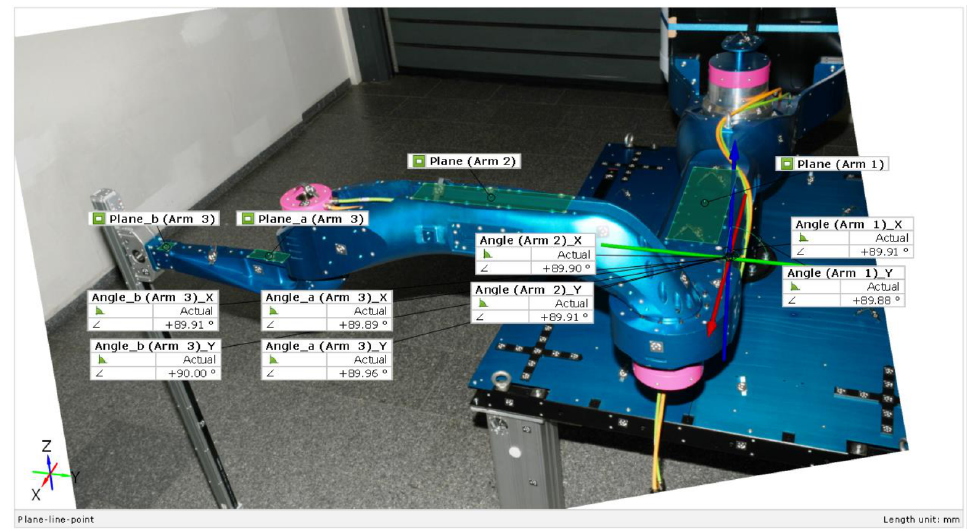
Figure 13. Arm angle measurement (measured between the normal to the plane and the correspond- ing axis of the coordinate system) (Position “L_1”).